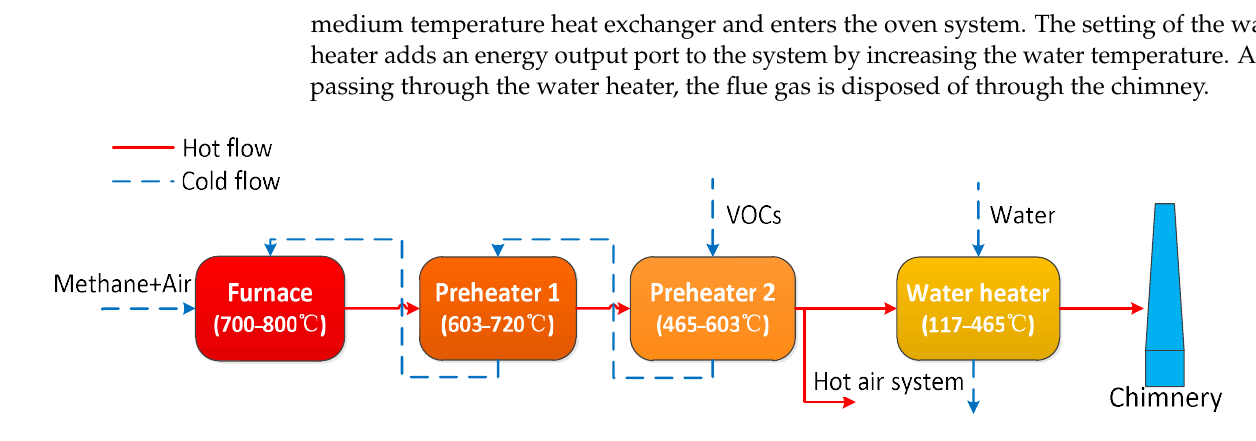
Table 1. Feeding parameters.